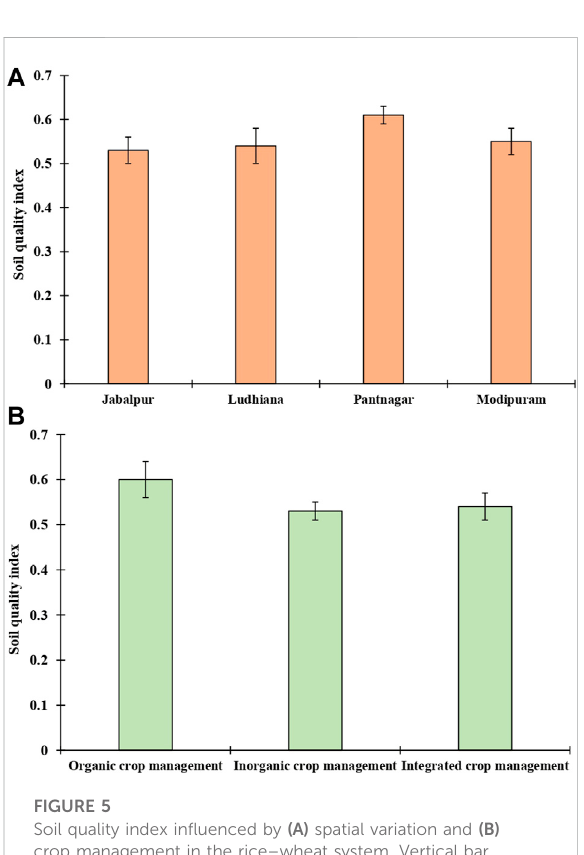
FIGURE 5 Soil quality index in fl uenced by (A) spatial variation and (B) crop management in the rice – wheat system. Vertical bar represents a standard error (SE) of